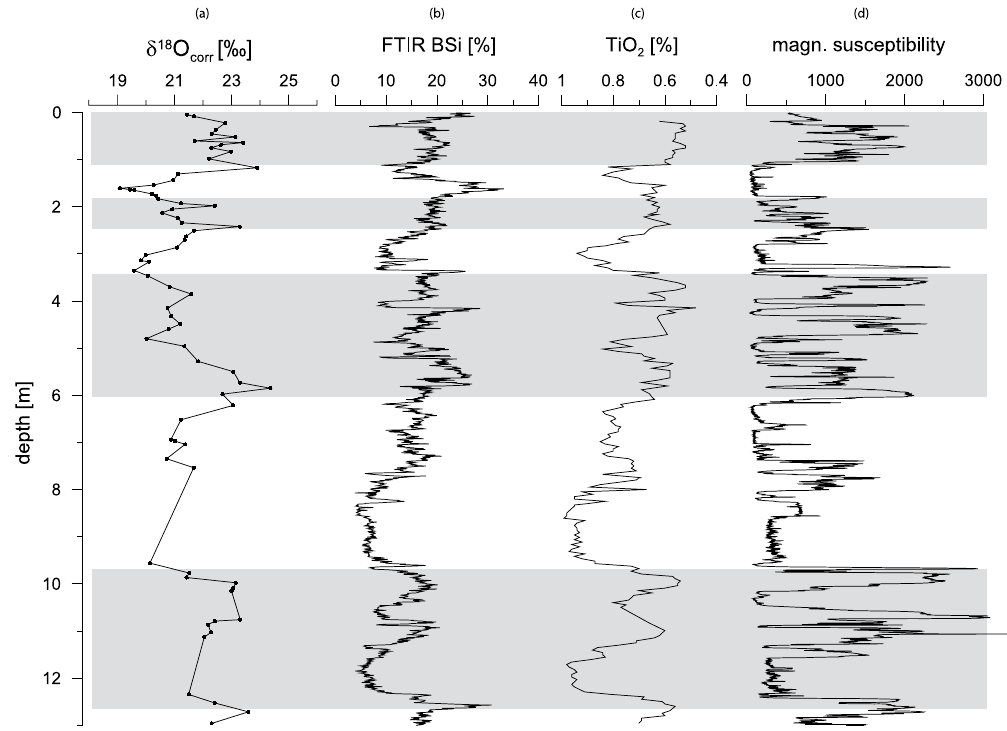
Fig. 7. Comparison of the (a) δ 18 O diatom record with other Lake El’gygytgyn records: (b) TiO 2 [%], (c) BSi [%] (both Frank et al., 2012) analysed with FTIRS (Ros´en et al., 2010) and (d) magnetic susceptibility for core Lz1024. Shaded parts indicate interglacial